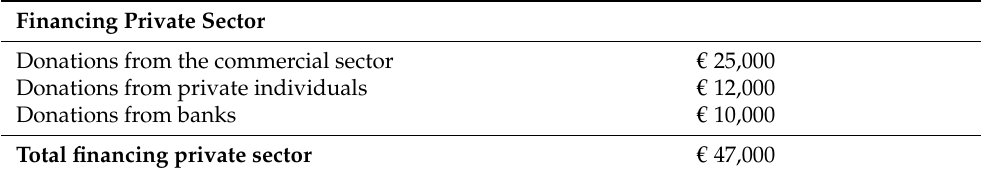
Table 5. The mix of private financings.